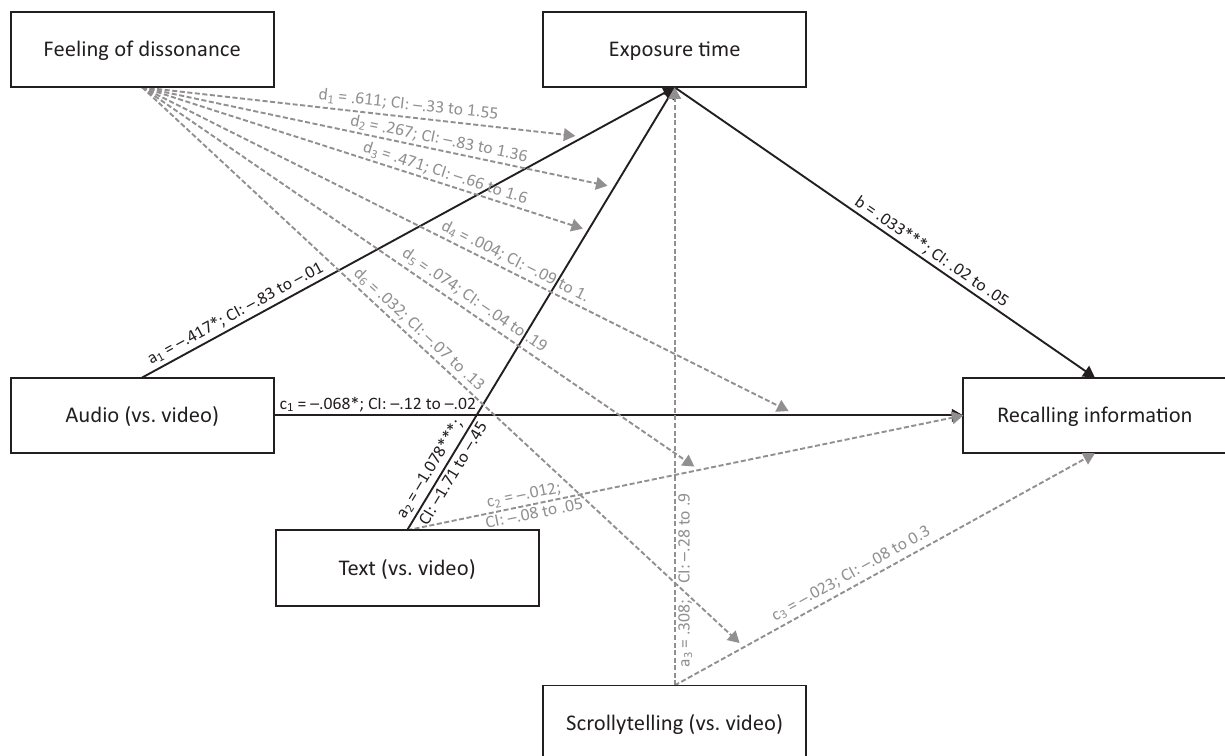
Figure 1. Moderated mediation model. Notes: Numbers represent path coefficients calculated via bootstrapping with 5,000 bootstrap samples and 95% bias-corrected confidence intervals. Video serves as the reference category. Solid lines indicate significant paths. * p < .05, ** p < .01, *** p <